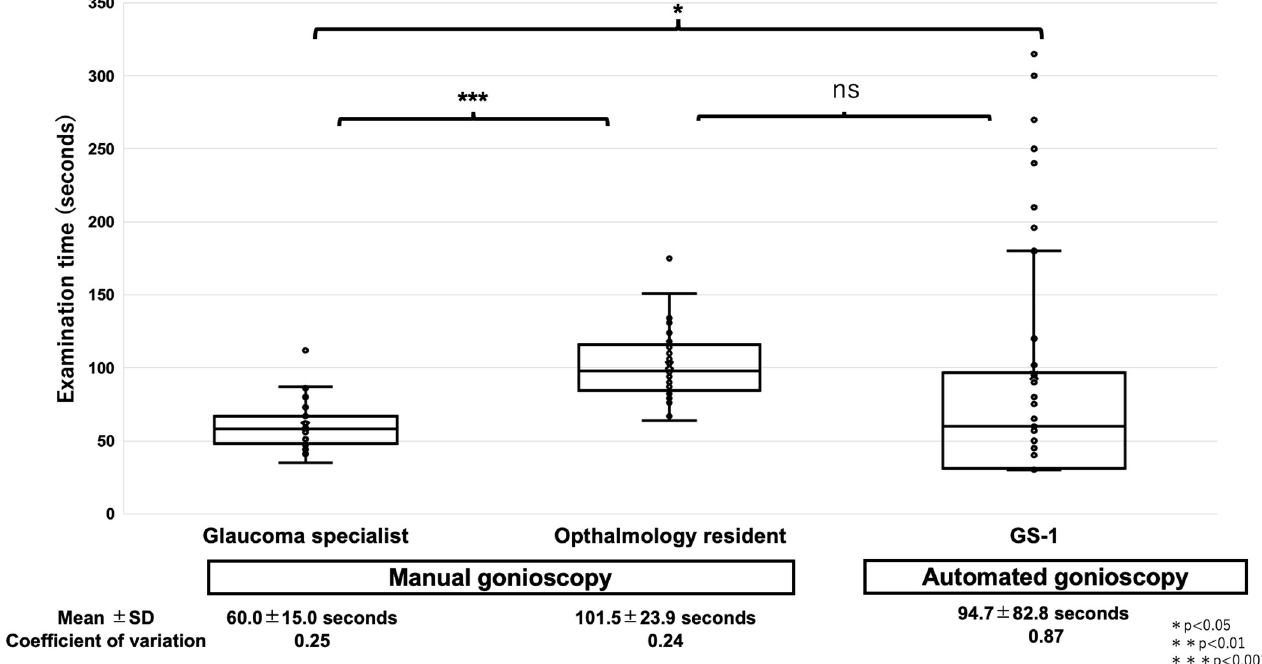
Fig 3. Analysis of the examination time between the glaucoma specialist, ophthalmology resident, and automated gonioscopy. * , ** , and *** represent p < 0.05, p < 0.01, and p < 0.001, respectively. ns represents statistically not significant.